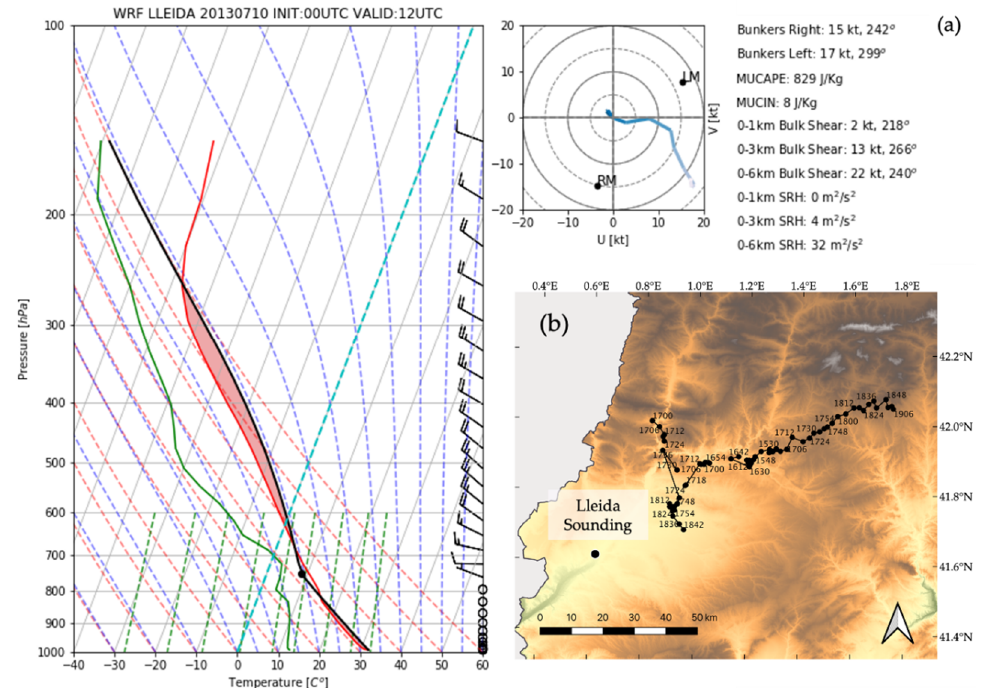
Figure 11. ( a ) Forecasted WRF sounding for Lleida on 10 July 2013, initialized at 00 UTC and valid at 12 UTC. The hodograph shows the wind velocity and direction up to 6 km height, in gradient blue, with dark blue starting from the surface. Potential left- (LM) and right-moving (RM) Bunkers supercell motions [62] are depicted with black dots. The black dot at ~750 hPa represents the Lifting Condensation Level (LCL). Sounding retrieved with MetPy Python’s module [63]. ( b ) Lleida WRF sounding location with respect to storm track.